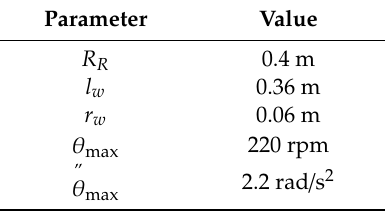
Table 5. Robot geometric parameters and kinematic limits.